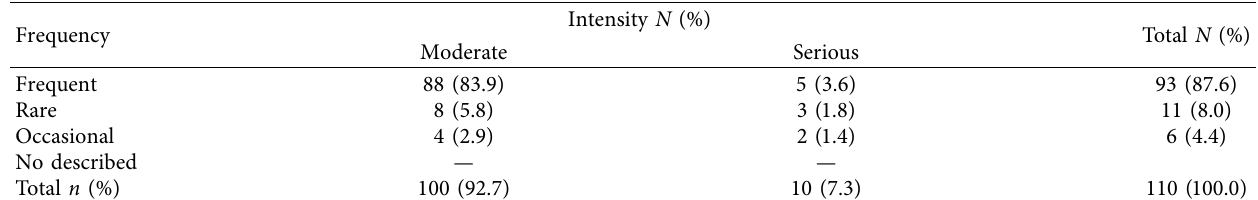
Table 2: Adverse reactions by intensity and frequency.